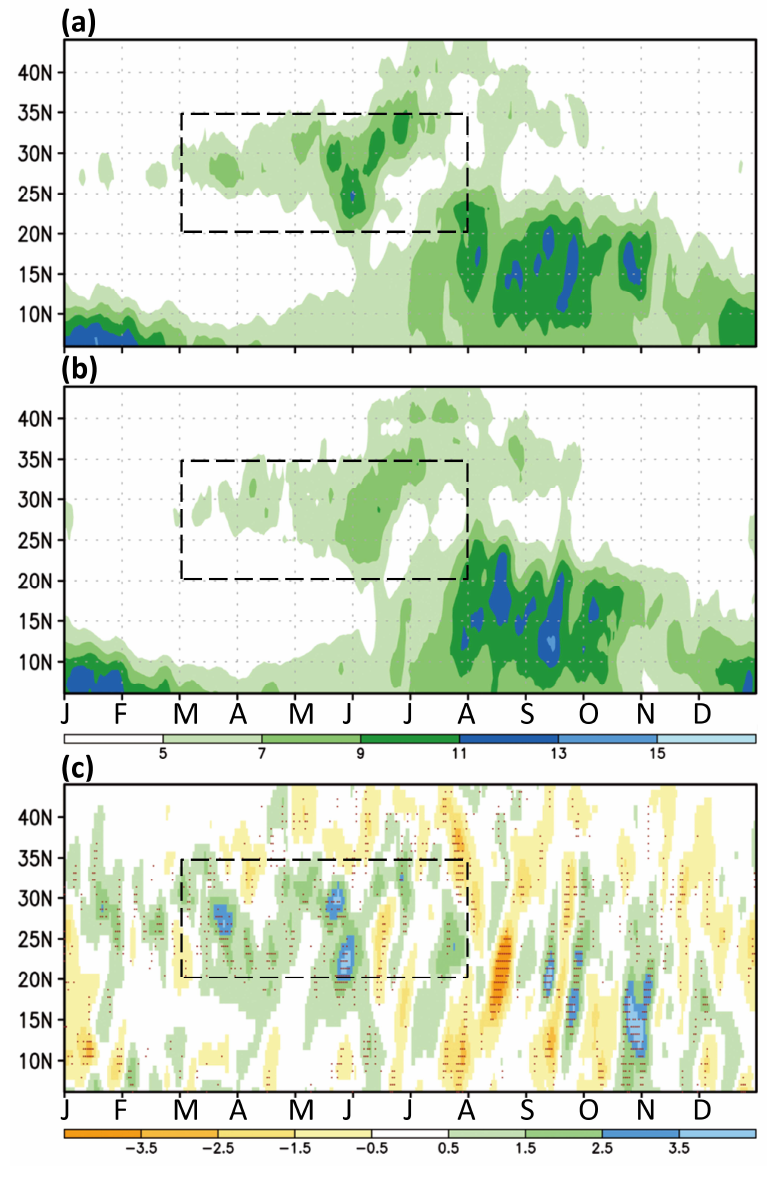
Figure 10. Same as Figure 1 except for ( a ) AA simulation; ( b ) IP0 simulation; and ( c ) AA minus IP0 simulation. Subtropical East Asia (110° E–140° E, 20° N–35° N) in March–July (i.e., spring rain and Meiyu) is marked by the dotted-line box. Dots denote that the differences have a confidence level of 90%.